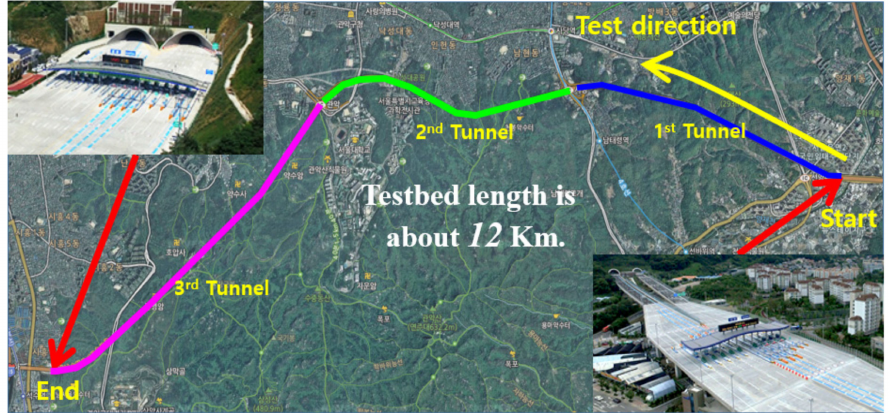
Figure 3. Test bed for tunnel navigation